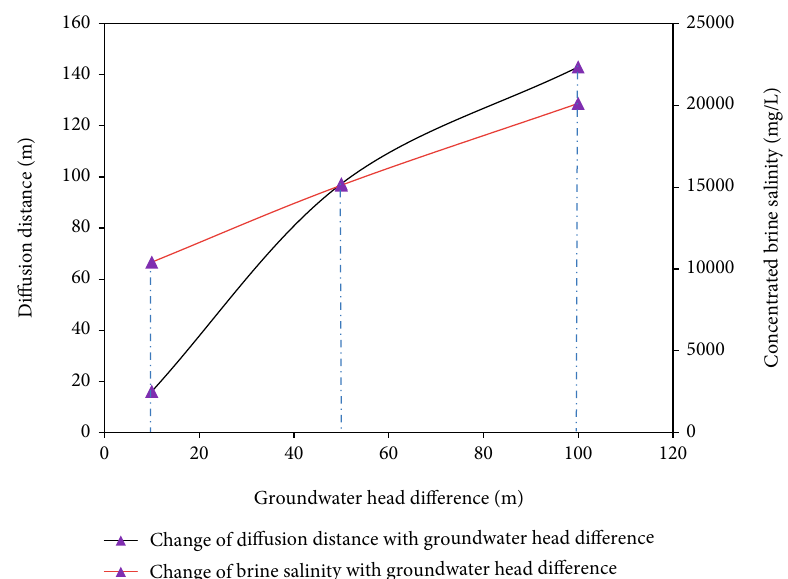
Figure 8: Relationship curve between the di ff usion distance of concentrated brine, the groundwater head di ff erence, and the salinity at the outer wall of the underground storage after 30 years of long-term penetration. Table 6: Increase in simulated data for 50 years of long-term penetration compared to 30 years of long-term penetration. Di ff usion Groundwater head di ff erence